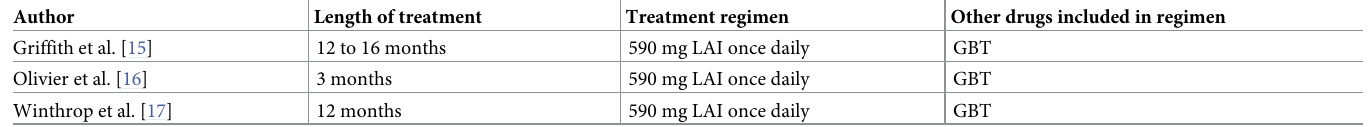
Table 2. Intervention characteristics.